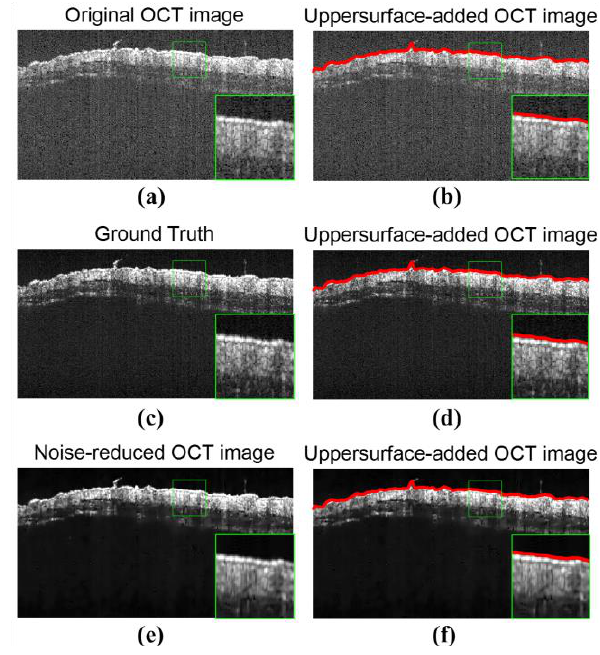
Figure 6. The background reduction. ( a , c ) Original OCT image and the ground truth, ( b , d ) the upper surface boundary in the original OCT image and the ground truth, ( e ) OCT image with speckle noise reduction with E2PGICMA ( σ = 20), ( f ) upper surface boundary of speckle-reduced OCT image.